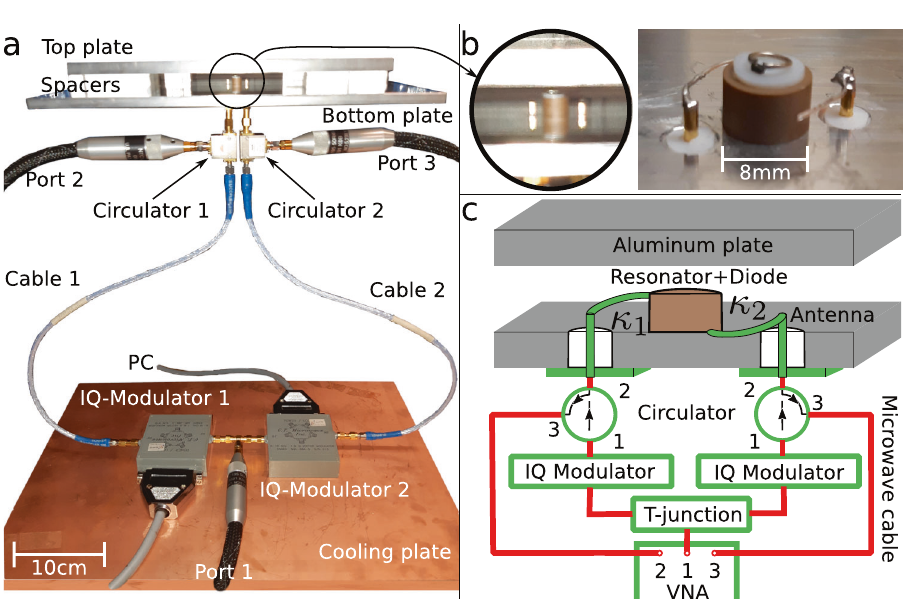
Fig. 1 The experimental setup. a Photograph of the experimental system including the connections. The scale is given on the lower left. b Zoom showing the experimental non-linear system consisting of a cylindrical dielectric resonator (permittivity ϵ r ≈ 36, radius = 4 mm, height = 5 mm) where a short- circuited diode is situated above separated by a 1 mm high Te fl on spacer (permittivity ϵ r = 2.1 with the two transmitting/receiving antennas, where the distance between the central parts of the antennas is 15 mm. The resonator is sandwiched between two aluminum plates with a distance 16 mm. The scale given corresponds to the diameter of 8 mm of the resonator. c Sketch detailing the setup. IQ-modulator stands for In-phase and Quadrature vector modulators, VNA for Vector Network Analyzer, PC for Personal Computer, and κ 1 and κ 2 for the coupling strengths of the antennas. The coaxial cables have a length of 50 same resonant frequency ϵ n = ϵ ≈ 6.7 GHz and model the left and right antennas (leads). They are coupled with one another via a (real) coupling constant H n , n + 1 = ν giving rise to a dispersion relation ω ¼ ϵ þ 2 ν cos ð k Þ ( k ∈ [0, 2 π ] is the wave-vector of a resonator ( n = 0) with the left ( n < 0) and to the right ( n > 0) ¼ κ ¼ j κ j e (cid:2) i ϕ ¼ κ ¼ j κ j e (cid:2) i ϕ leads are H (cid:2) 1 and H 0 ; 1 2 , 1 ; 0 1 1 2 2 respectively. The non-linear resonator at site n = 0, has a reso- nant frequency ϵ 0 = ϵ + Ω ( ∣ ψ 0 ∣ 2 ). The complex function ∣ 2 ) = Ω ∣ ψ ∣ 2 ) + i Ω ∣ ψ ∣ 2 ) depends on the local fi eld Ω ( ∣ ψ 0 r ( 0 i ( 0 intensity ∣ ψ 0 ∣ 2 . Measurements of one-sided transmission mea- model of equation (1) are achieved when j 2 Þ (cid:4) β þ β j ψ j 2 ; ð 2 Þ Ω ðj ψ 0 0 1 0 where β 0 = (67.74 + 3i) MHz, β 1 = ( − 0.141 + 0.41i) MHz mW − 1 while ν = 0.1 GHz.